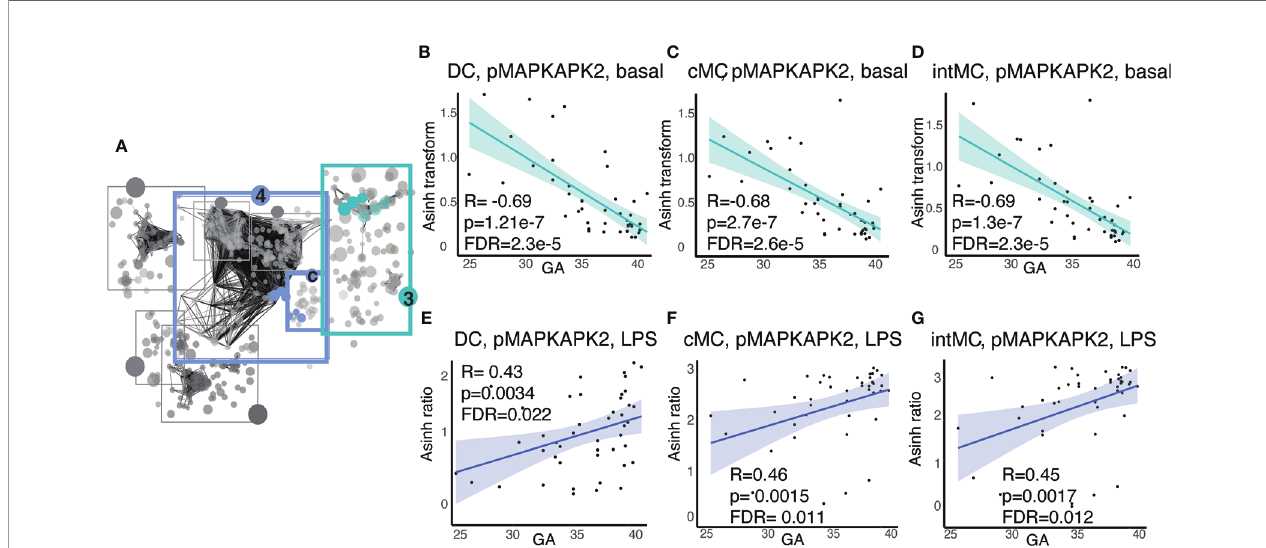
FIGURE 5 | Antigen presenting cell subsets exhibit decreasing basal MAP-kinase/NF k B pathway signaling with GA but increasing signaling responsiveness to LPS. (A) Community 3 contains information on 123 immune features corresponding to the basal signaling of the MAP-kinase/NF k B pathway, and community 4c contains information on 16 immune features corresponding to the response of the same pathway to LPS. (B – D) Highlighted immune features in community 3 show decreasing basal pMAPKAPK2 signaling in antigen presenting cells. (E – G) Highlighted immune features in community 4c show increasing pMAPKAPK2 signaling in response to LPS in the same cells. Spearman